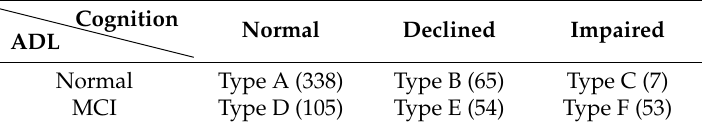
Table 3. Combination of MCI and ADL.